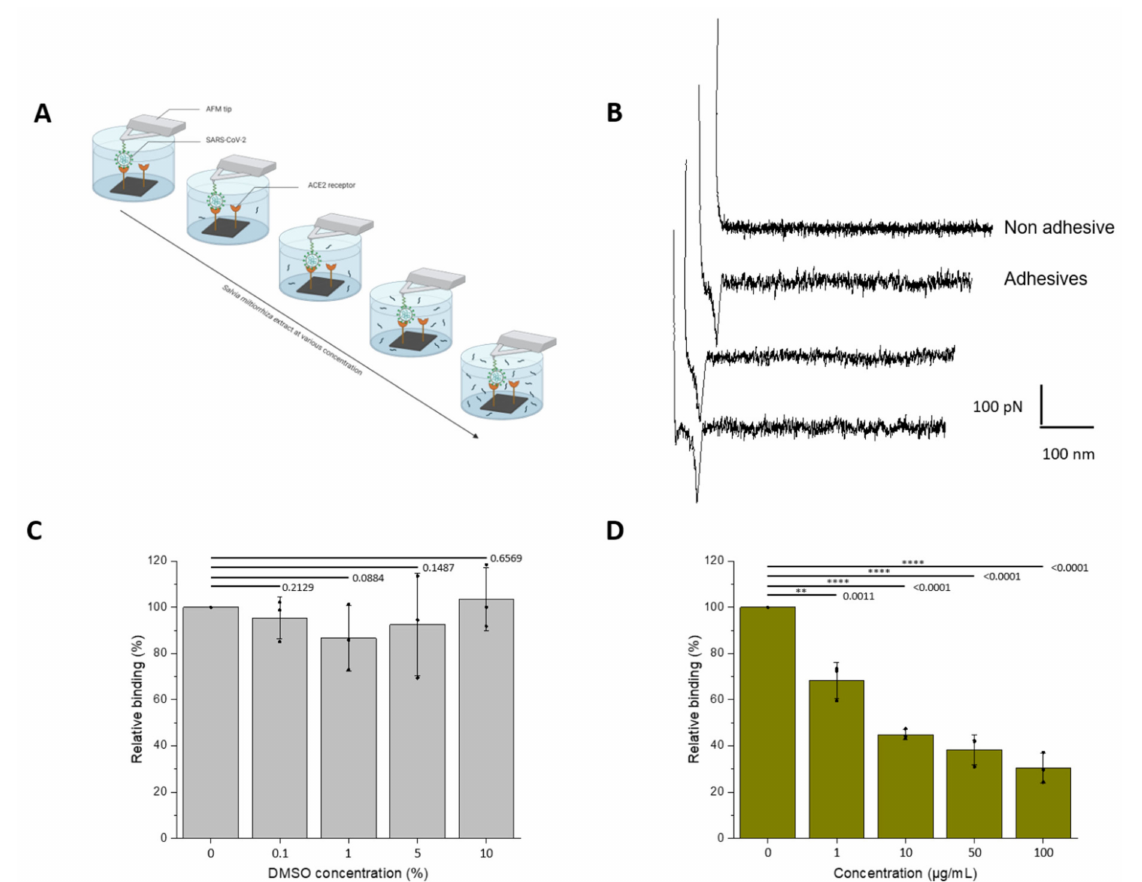
Figure 2. Assessment of the inhibitory effect of a S. miltiorrizha extract powder on the interaction between the UV-inactivated SARS-CoV-2 virions and ACE2 monitored by AFM. ( A ) The inhibitory potential of roots S. miltiorrhiza extract is assessed by measuring the binding probability between the UV-inactivated SARS-CoV-2 immobilized on the AFM tip and the ACE2 receptor grafted on a model surface, before and after incubation with the extracts at increasing concentrations (0, 1, 10, 50, and 100 µ M, respectively). ( B ) Examples of non-adhesive (above) and adhesive (below) force distance curves recorded between UV-inactivated SARS-CoV-2 virions-functionalized AFM tips and ACE2-coated model surfaces showing specific adhesion events. ( C , D ) Histograms showing the binding probability (BP, expressed in %) with the different concentrations of extracts (0, 1, 10, 50, and 100 µ M) or DMSO for the control (0, 0.01, 0.1, 0.5, and 1%). The error bar indicates s.d. of the mean value. One data point belongs to the BP from one map. The figure on panel a was created with Biorender.com (accessed on 10 March